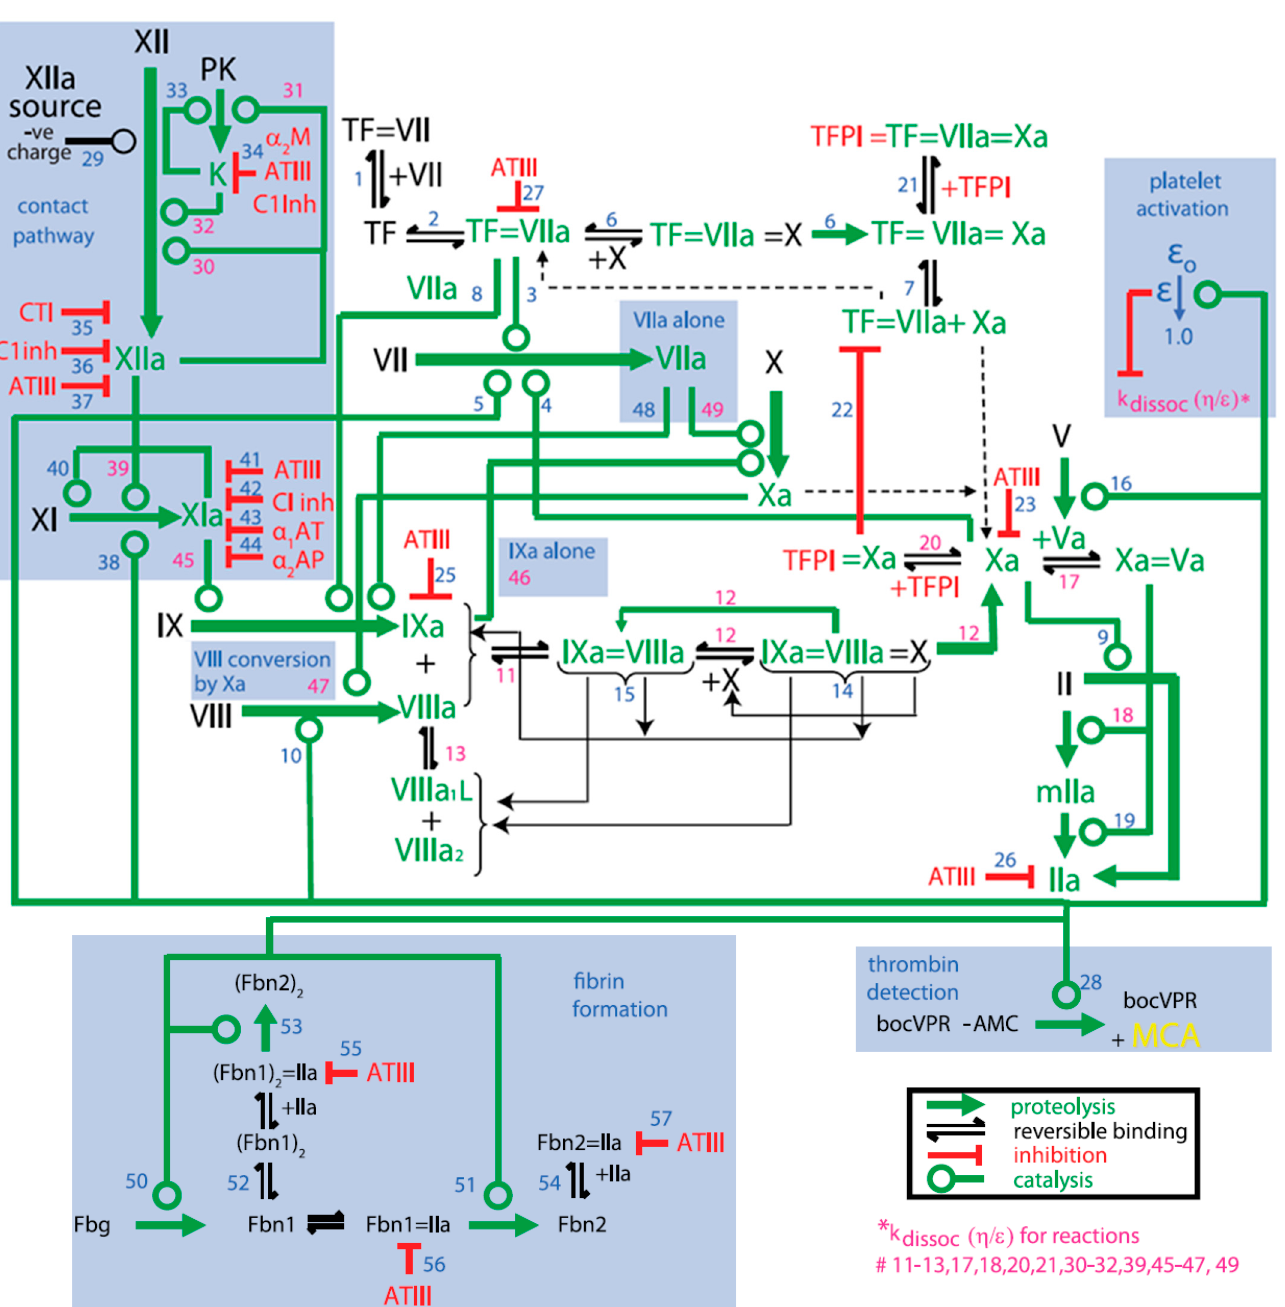
Figure 3. Schematic of the Platelet–Plasma dynamics from the Chatterjee model [5]. Blue highlighted portions represent additions to the Hockin–Mann model [2]. Alpha-1 antitrypsin ( α 1AT); alpha-2 antiplasmin ( α 2AP); alpha 2-macroglobulin ( α 2M); antithrombin-III (ATIII); C1-inhibitor (C1Inh); corn trypsin inhibitor (CTI); fibrin I (Fbn1); fibrin II (Fbn2); fibrinogen (Fbg); kallikrein (K); meizothrombin (mIIa); platelet activation factor ( ε ); prekallikrein (PK); tissue factor (TF); prothrombin (II); thrombin (IIa); tissue factor pathway inhibitor (TFPI). Blue numbers are the reaction steps in the model and pink numbers are those reactions whose dissociation rate constant is modified by the platelet activation factor ( ε ).